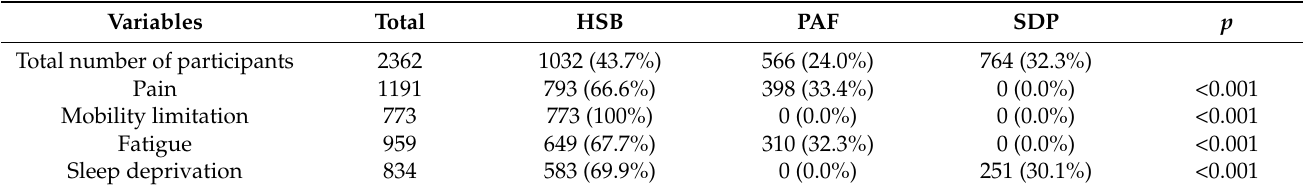
Table 2. Classification of symptoms in the symptom cluster